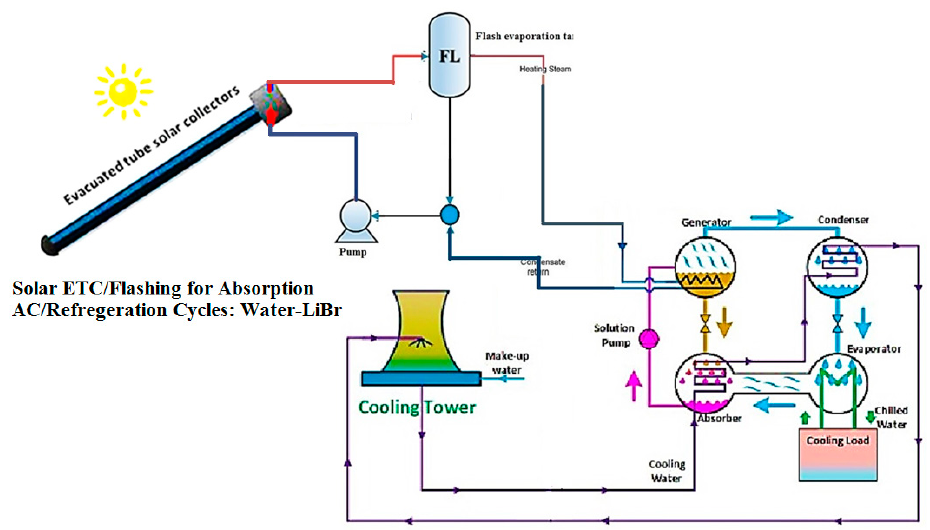
Figure 1. Tube solar collector-assisted H2O–LiBr absorption air conditioning cycle.